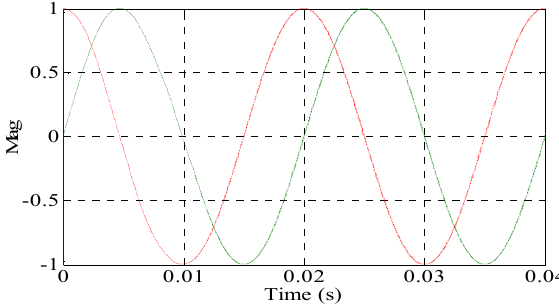
Figure 7. Sine and cosine function from the unit vector circuit.